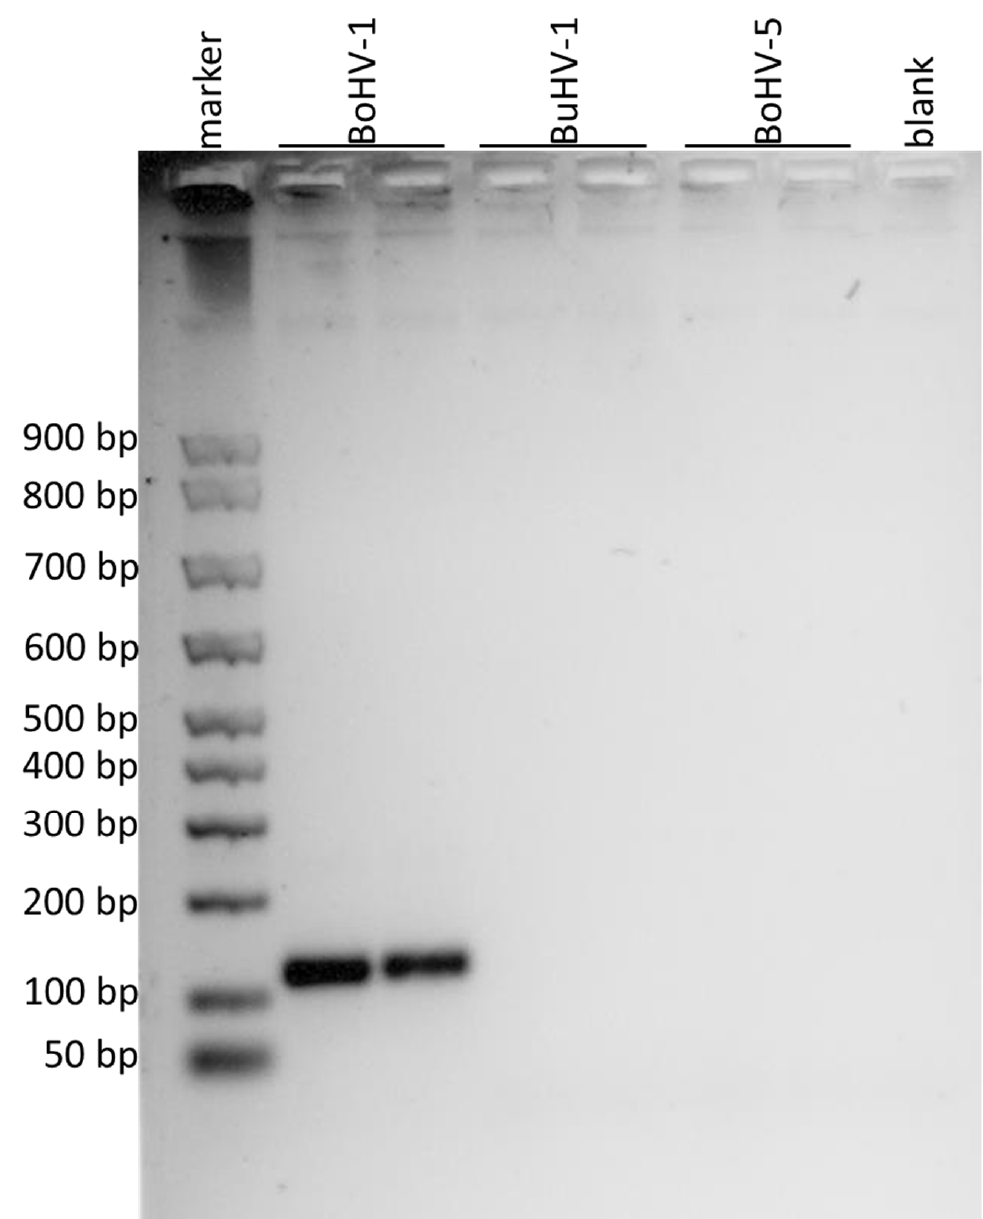
Figure 2. Agarose gel electrophoresis of the amplified products obtained by using the primers for the portion of gD gene. The DNA marker in the first lane showed the first band at 50 bp, the second at 100 bp and the subsequent ones at 100 bp from each other. BoHV-1 was loaded in the second and third lanes, BuHV-1 in the fourth and fifth, BoHV-5 in the sixth and in the seventh and the eighth lane was the negative control (blank). Amplification products of 110 bp were observed for BoHV-1 .